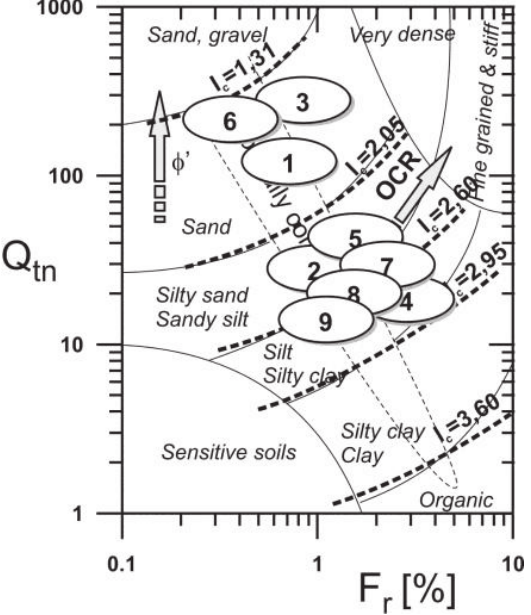
Figure 5. Location of the tested soils the soil behavior chart according to Robertson (2009).